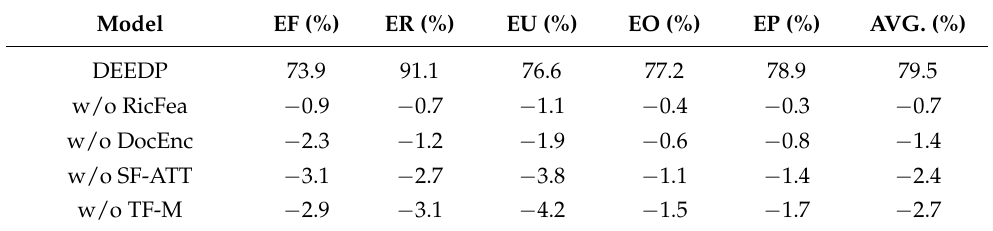
Table 5. F1 scores of ablation tests on DEEDP variants for all event types and the averaged ones (Avg.).